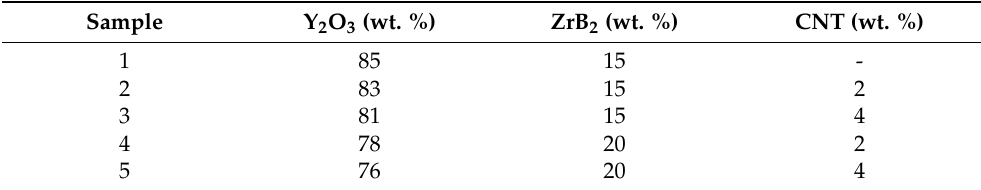
Table 1. The mass percentage (wt.%) for different Y 2 O 3 /ZrB 2 /CNT